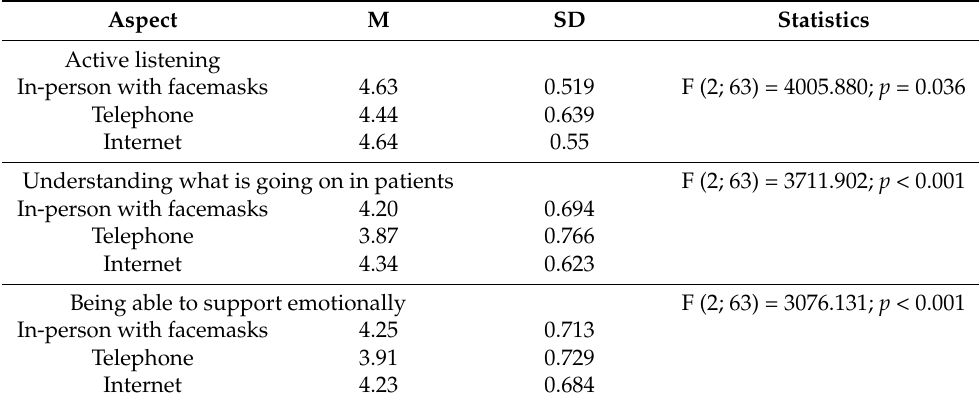
Table 4. Ratings of different aspects of the psychotherapy process per treatment format ( n =